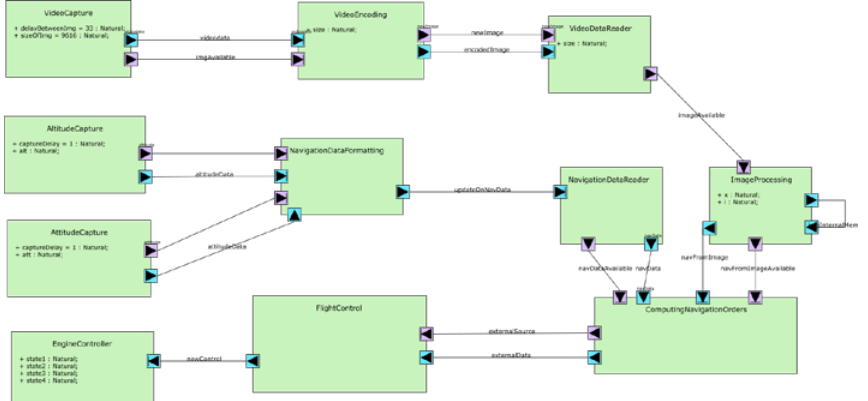
Figure 5: Functional architecture of the